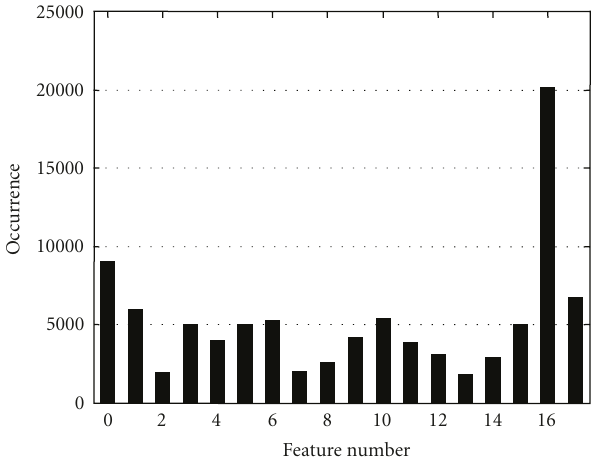
Figure 5: Sample histogram of original image Figure 2, 16 coded feature numbers plus flags for low- and high-local contrast (16, resp.,